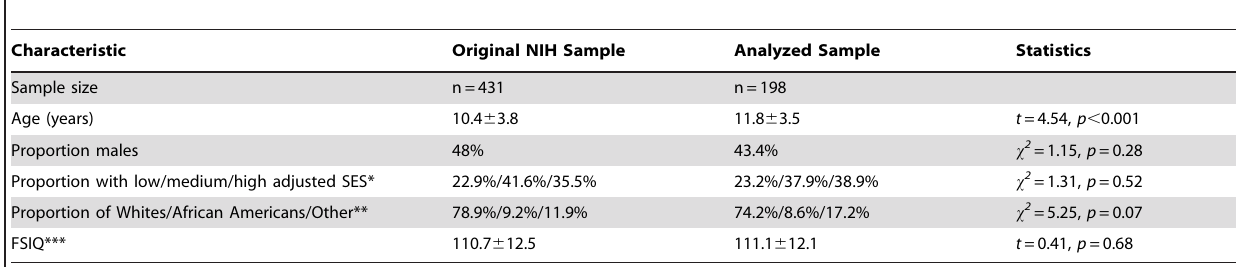
Table 1. Demographic and FSIQ characteristics of original NIH sample and analyzed